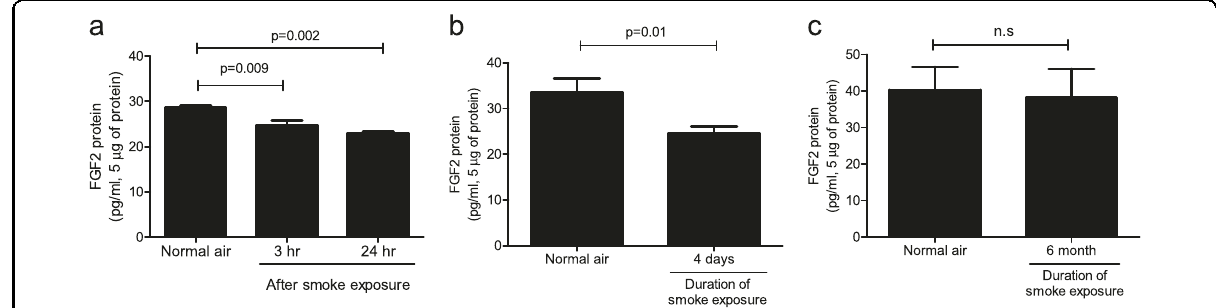
Fig. 1 Fibroblast growth factor-2 (FGF-2) levels in lung lysates decreased in response to short-term smoke exposure. a – c FGF-2 levels were measured in 5 μ g of lung lysate using an enzyme-linked immunosorbent assay. a Mice were exposed to cigarette smoke once, and lung tissues were obtained 3 and 24 h after exposure ( n = 6 per group). b , c Mice were exposed to cigarette smoke for 4 days or 6 months, and lung tissues were collected 18 h after the last exposure ( b n = 12 per group, c n = 5 per group). P- values were determined by the Mann – Whitney